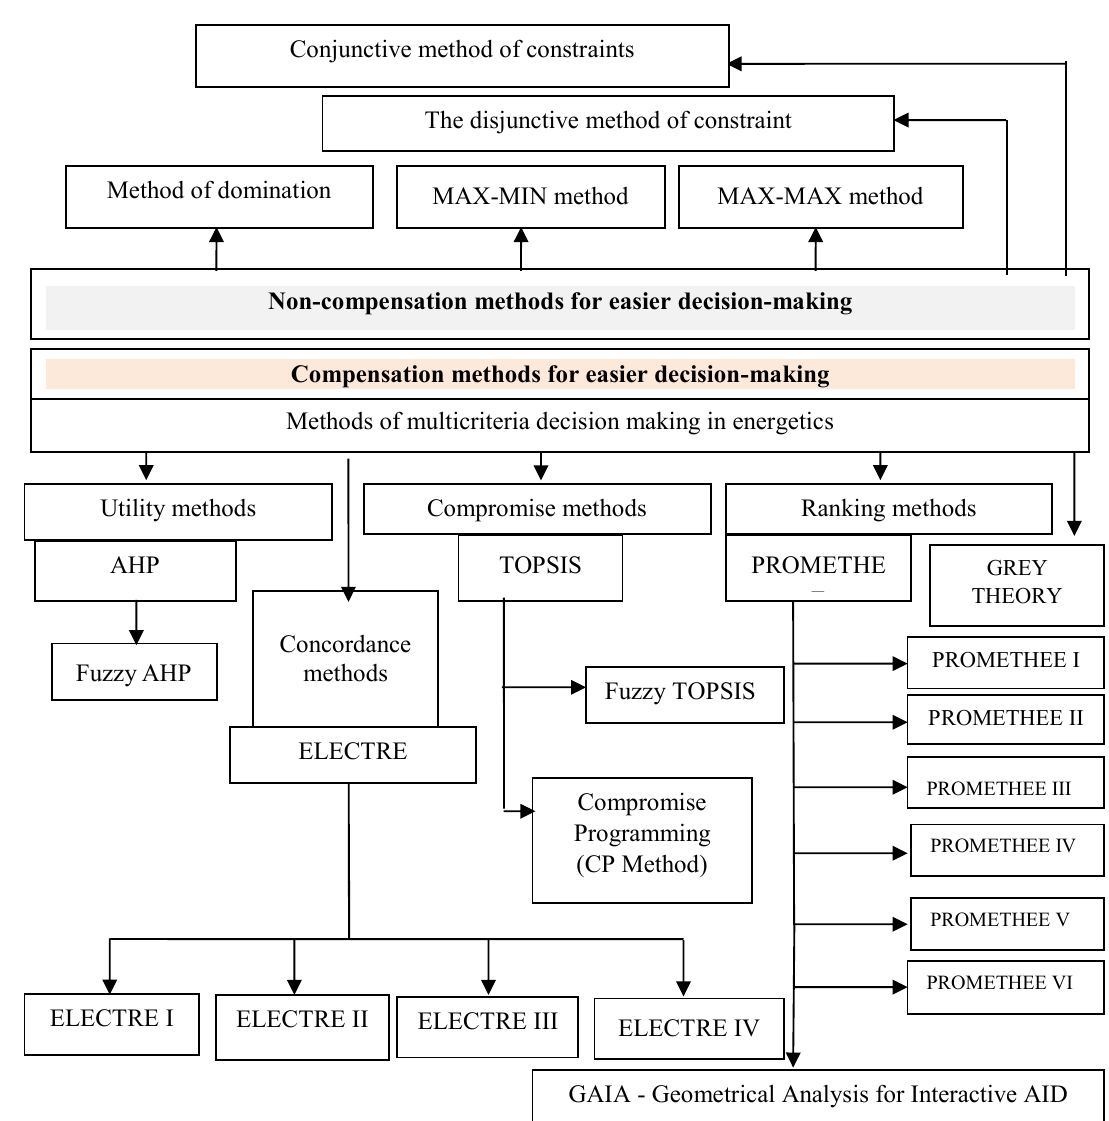
Figure 4. Hierarchical review of decision-making methods in energy (Milovanović et al.,